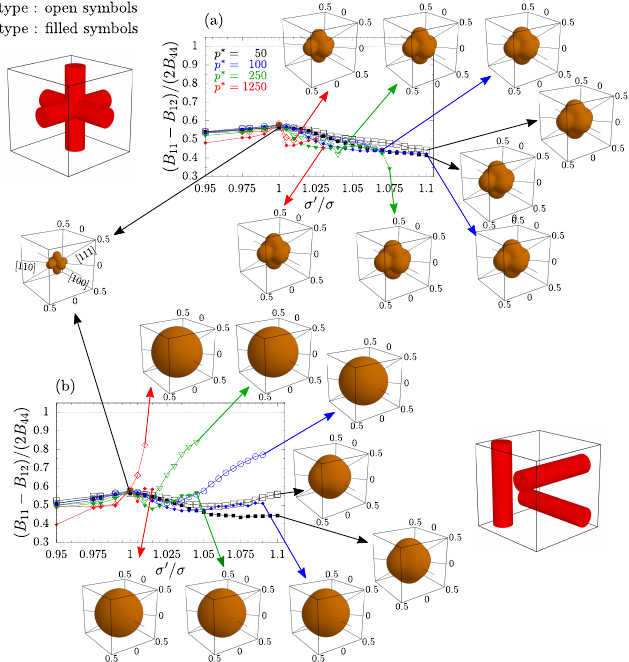
Figure 11. Calculated relative isotropy criterion (Equation (9)) for studied systems with ( a ) crossing and ( b ) separate nanochannel inclusions. The inserts present the average PR, plotted in the spherical coordinate system, for, respectively, the marked values of σ (cid:48) / σ (corresponding to the maximal studied values of σ (cid:48) / σ ), for all systems studied and under all pressures (indicated in colors). The open and closed symbols correspond to the D -type and S -type systems,